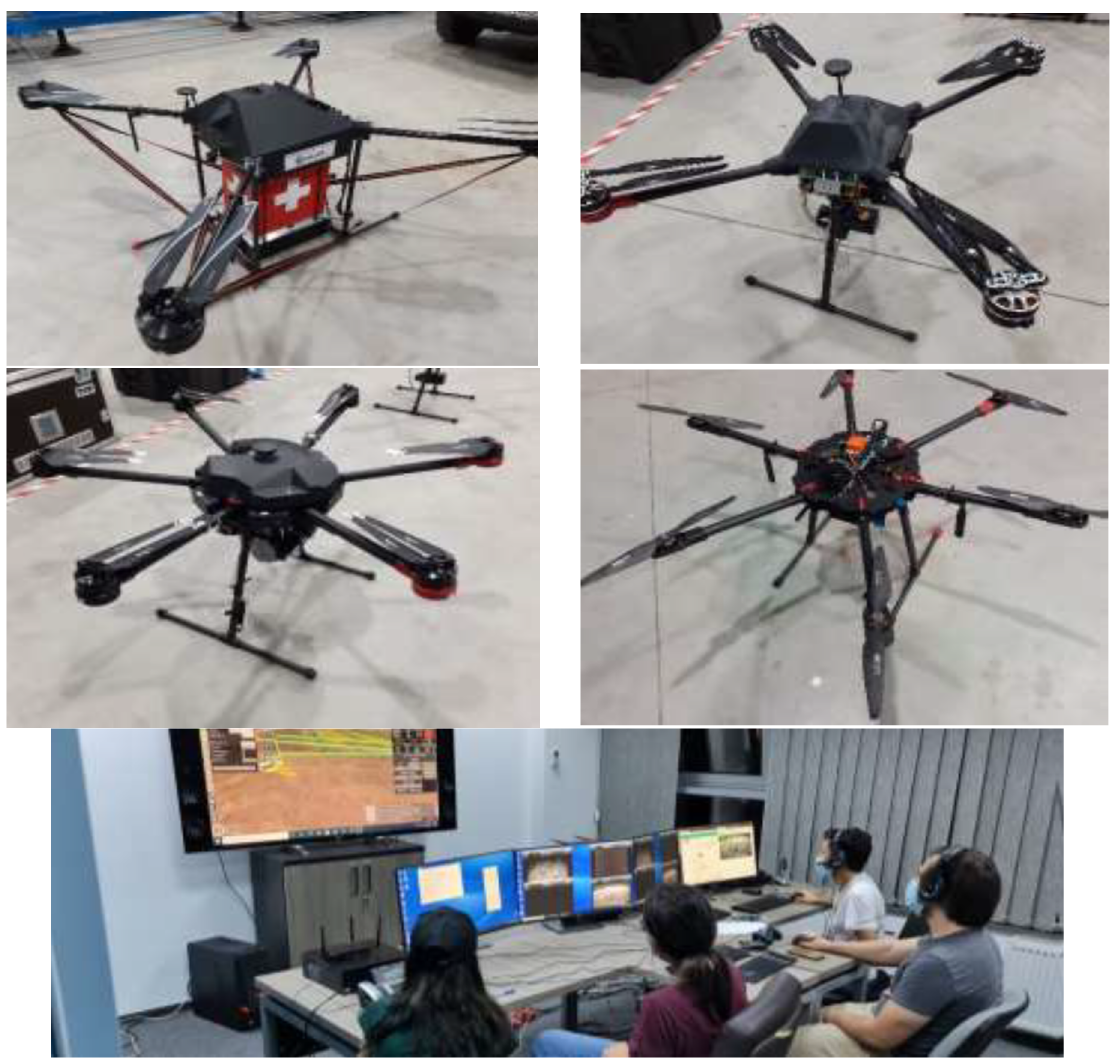
Figure 1. System components and concept of operation in 19 Sol/UAV.